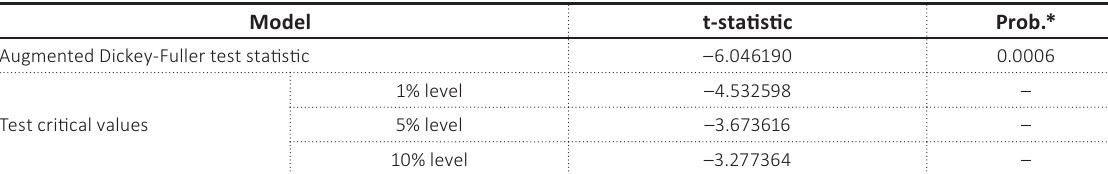
Table 4. China’s inflation rate: first-degree difference test –